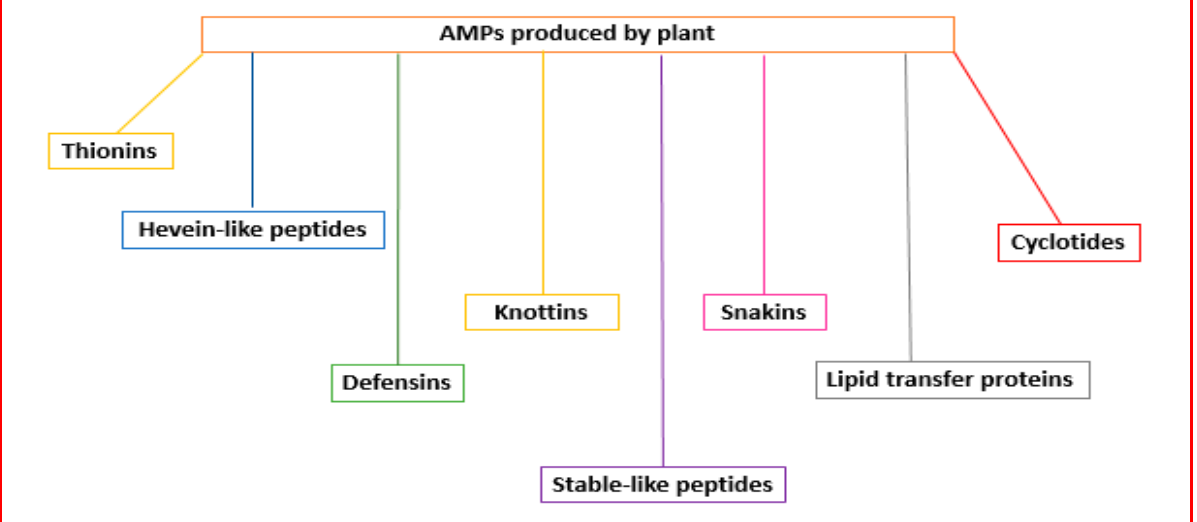
Figure 5. Classification of the AMPs produced by plants.